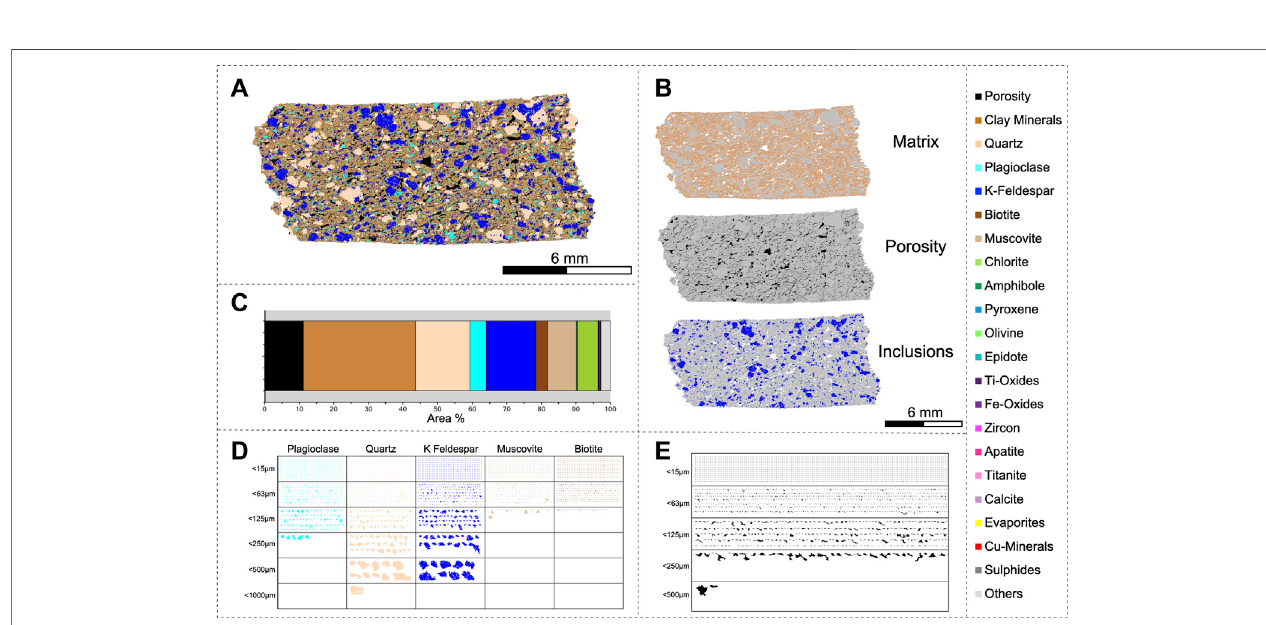
FIGURE5| iDiscover fi ltersusedforautomatedmineralogicalanalysis.Sample2-G1A: (A) Mineralogicalmapoftheceramicfragment; (B) Mineralogicalmapofthe paste components; (C) modal mineralogy; and grading tables for mineral grains (D) and porosity (E) .